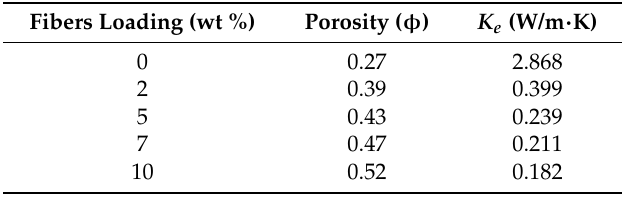
Table 6. Thermal conductivity of porous mortar for different